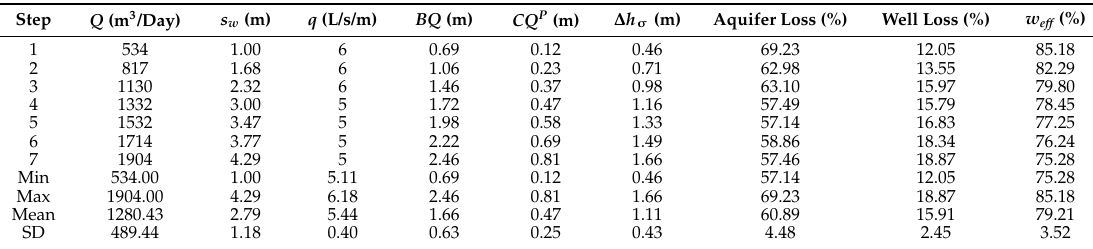
Table 2. Results from the step-drawdown test